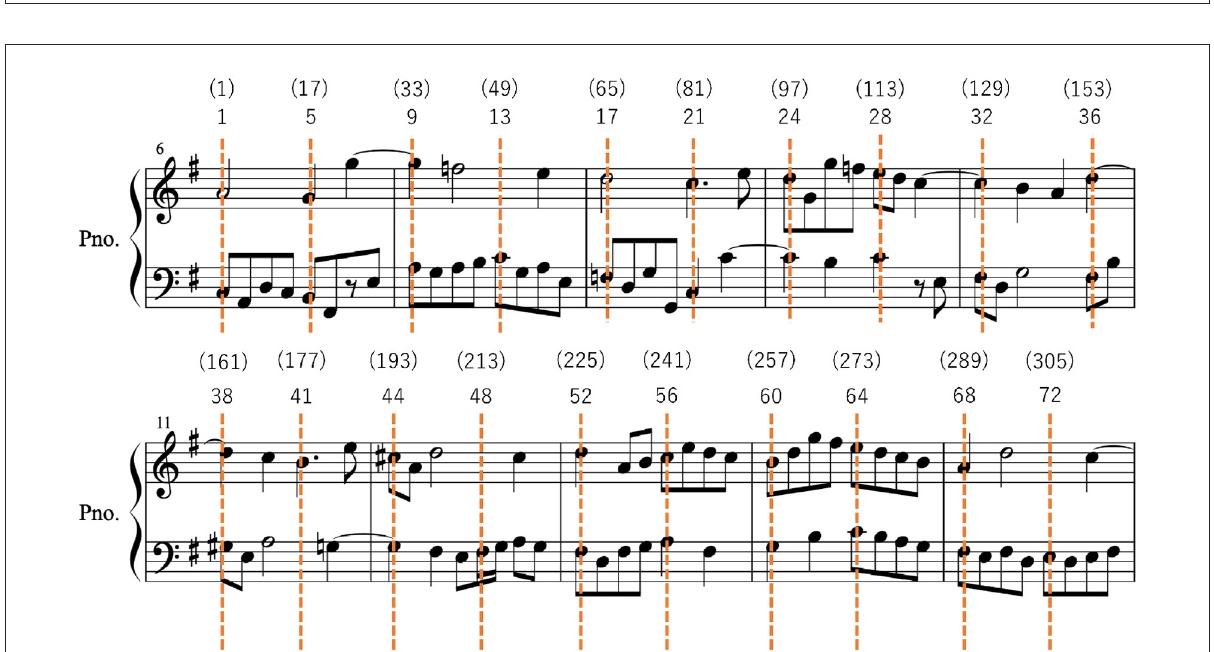
FIGURE2 An example of numbering notes in the targeted portion (6–15 measures) for N-EHS (without parentheses) and B-EHS (with parentheses), using score LM. If the participant was playing G 4 (in the treble clef) and B 2 (in the bass clef) in measure 6 when her fixation on G 3 (in the bass clef) in measure 7 ended, then N-EHS would be 5 (i.e., 10 – 5) and B-EHS would be 20 [ i.e., (37) – (17)].